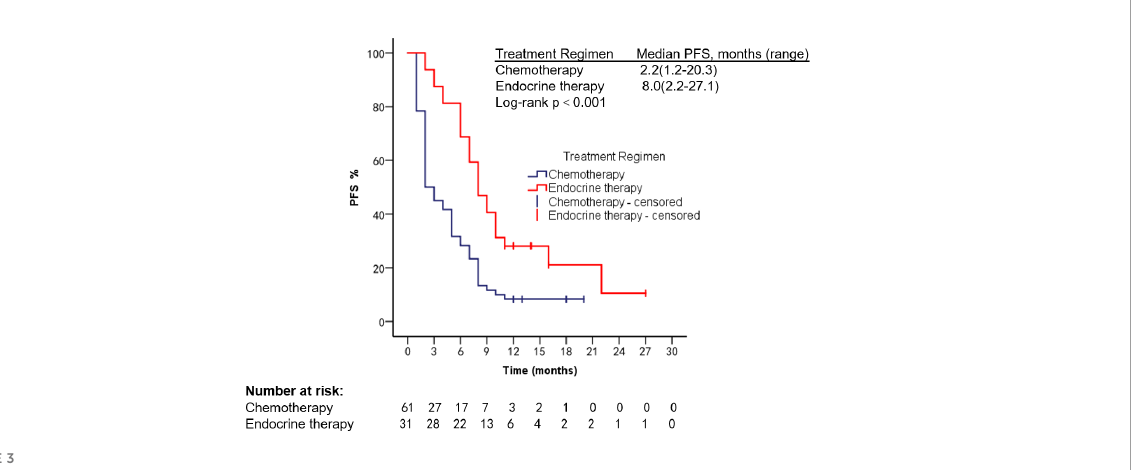
FIGURE 2 OS of all VC patients.